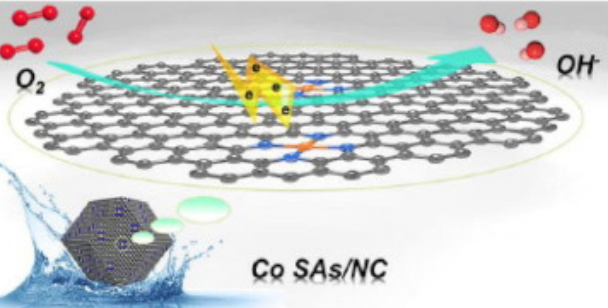
Figure 14. ORR by the Co SAs/NC catalyst with rich active Co sites. Reprinted with permission from Ref. [47]. Copyright © Elsevier B.V. 2022.